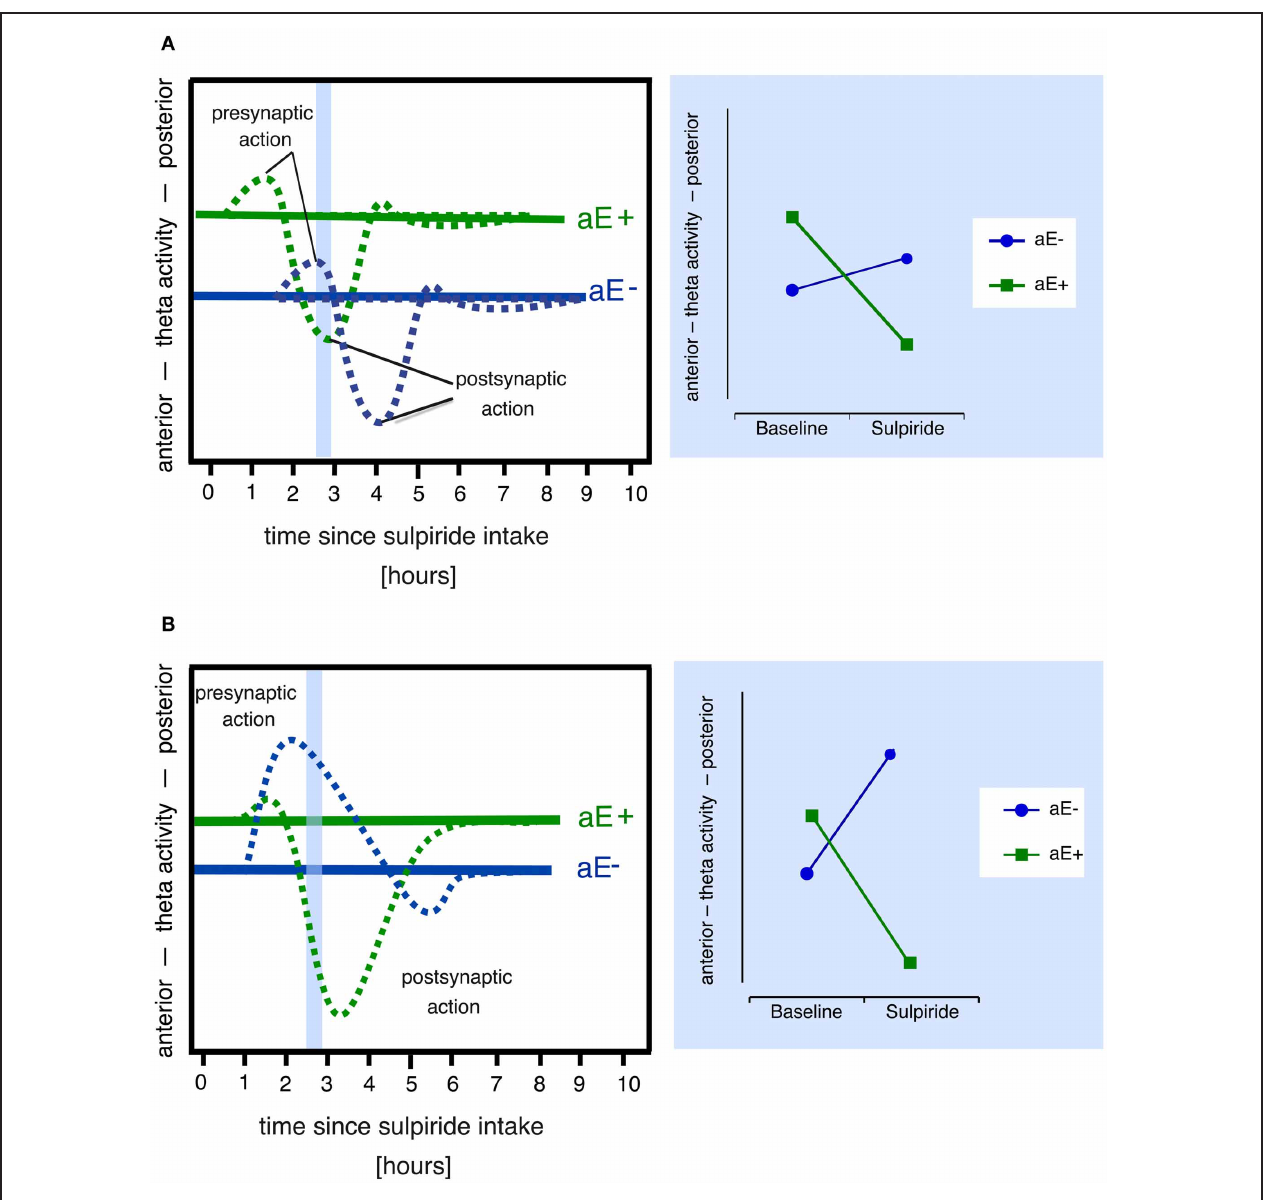
(disordinal interaction, see resulting Substance × aE plot on the right side), since, compared to baseline, aE + displays a shift toward anterior theta activity at 2.5h (due to postsynaptic action), whereas aE − exhibits a shift toward posterior theta (due to presynaptic action). Panel (B) Differential receptor sensitivities could also produce stronger presynaptic than postsynaptic effects in aE − resulting in a net presynaptic effect and a shift toward posterior theta, whereas stronger sensitivity to postsynaptic action in aE + results in a net postsynaptic effect and a shift toward anterior theta (marked light blue area), thus compared to baseline one observes a paradoxical effect (disordinal interaction, see resulting Substance × aE plot on the right side) at